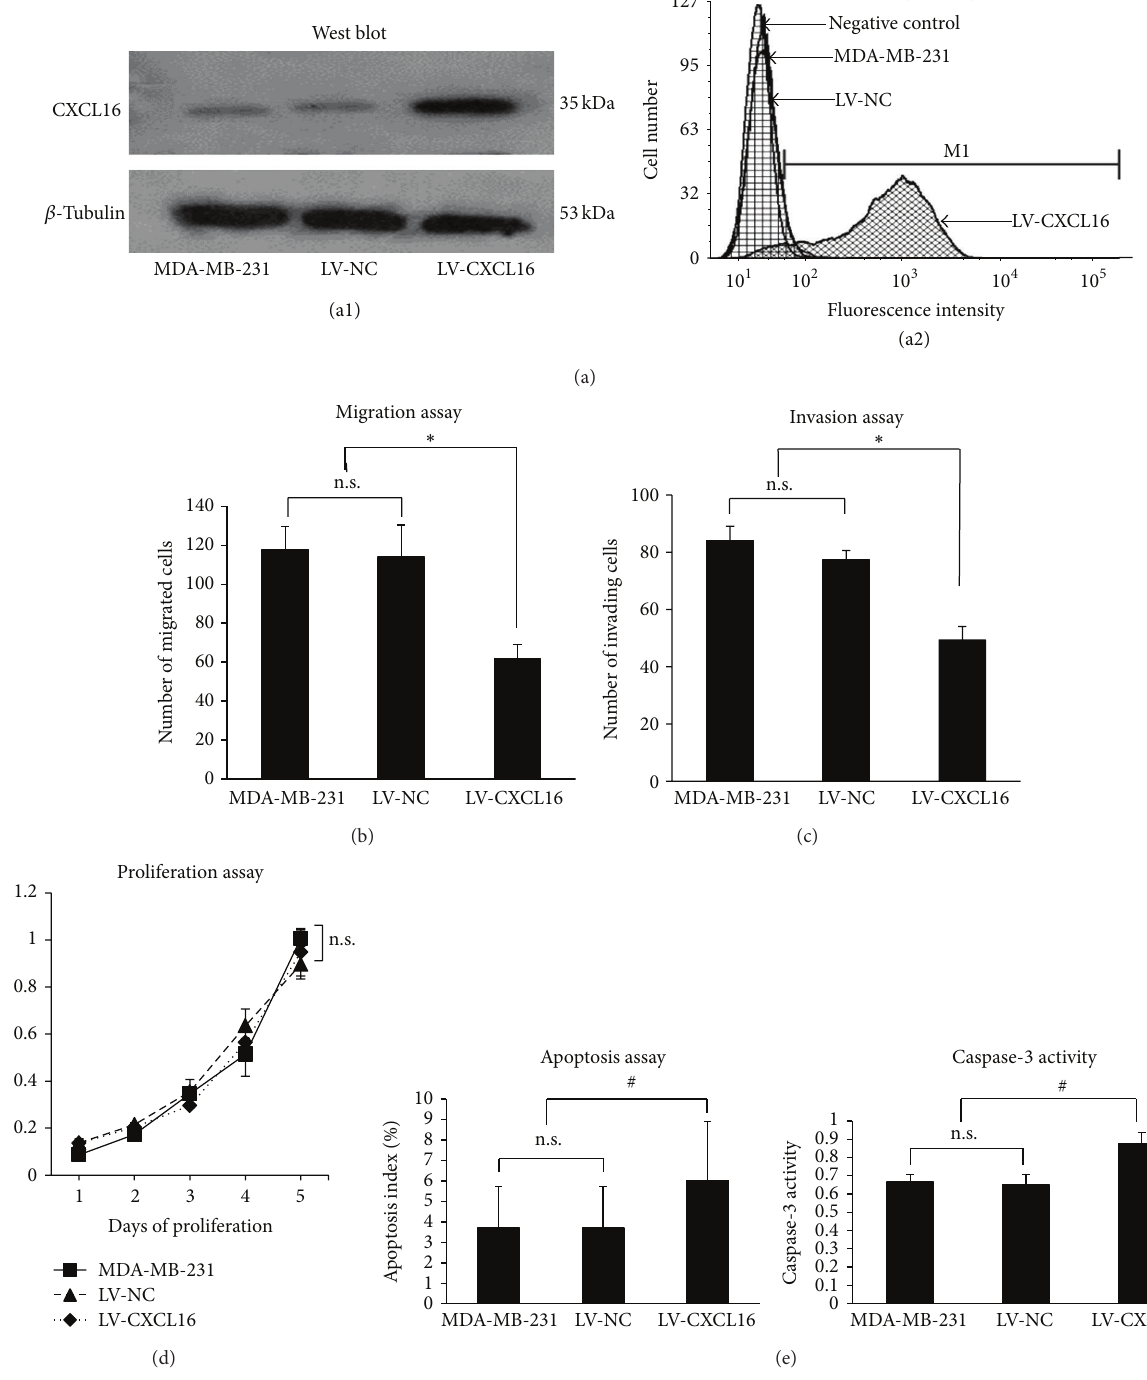
Figure 2: Overexpression of CXCL16 inhibited migration and invasion and promoted apoptosis, of MDA-MB-231 cells. MDA-MB-231 cells wereinfectedwithnegativelentivirus(LV-NC)orrecombinantCXCL16lentivirus(LV-CXCL16).120 hlatercellswerecollectedandmigration, invasion, proliferation, and apoptosis assays were conducted, respectively. (a) Recombinant CXCL16 significantly upregulated total CXCL16 (a1) and TM-CXCL16 (a2). (b) and (c) Overexpression of CXCL16 led to a decrease in migration (b) and invasion (c) of MDA-MB-231 cells. ∗ 𝑃 < 0.01 compared with MDA-MB-231 or negative control (LV-NC). n.s.: nonsignificant compared between MDA-MB-231 or negative control (LV-NC). (d) Proliferation of MDA-MB-231 cells was not affected by CXCL16 overexpression. n.s.: nonsignificant compared between MDA-MB-231 and negative control (LV-NC). (e) CXCL16 expression promoted apoptosis of MDA-MB-231 cells (left) in conjunction with enhanced caspase-3 activity (right). # 𝑃 < 0.05 compared with MDA-MB-231 or negative control (LV-NC). n.s.: nonsignificant compared between MDA-MB-231 and negative control